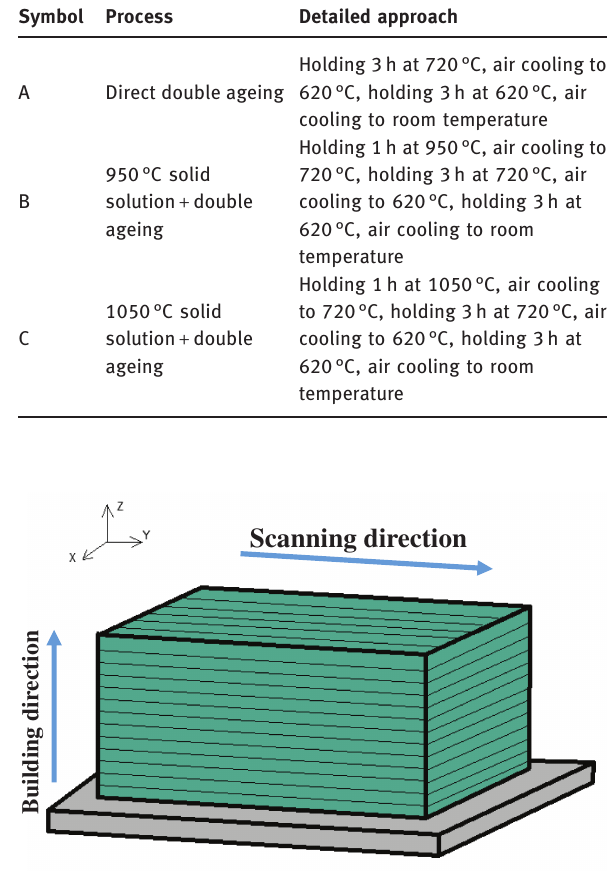
Figure 1: Theschematic of Inconel 718 Ni-based alloys fabricated by